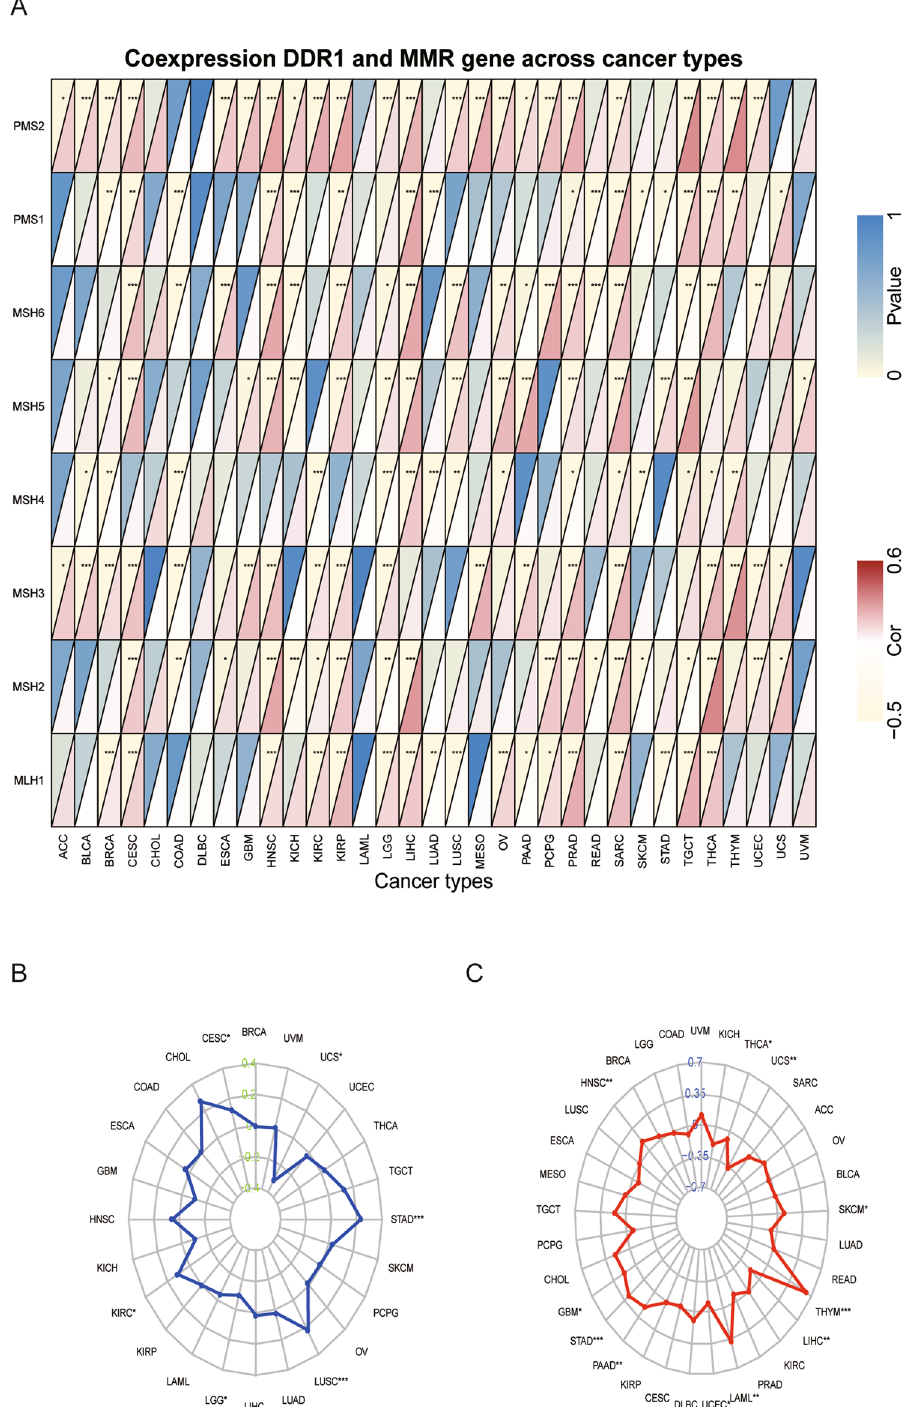
Figure 6. Association between DDR1 expression and mismatch repair (MMR) gene expression, microsatellite instability (MSI), and tumor mutational burden (TMB) across cancers. ( A ) Heatmap illustrating the relationship between DDR1 and MMR gene. The top left triangle represents the P-value, and the bottom right triangle represents the correlation coefficient. * P < 0.05, ** P < 0.01, *** P < 0.001. ( B ) Correlation between DDR1 expression and MSI across cancers. ( C ) Correlation between DDR1 expression and TMB across cancers. The value of black represents the range, and the curves of blue and red represent the correlation